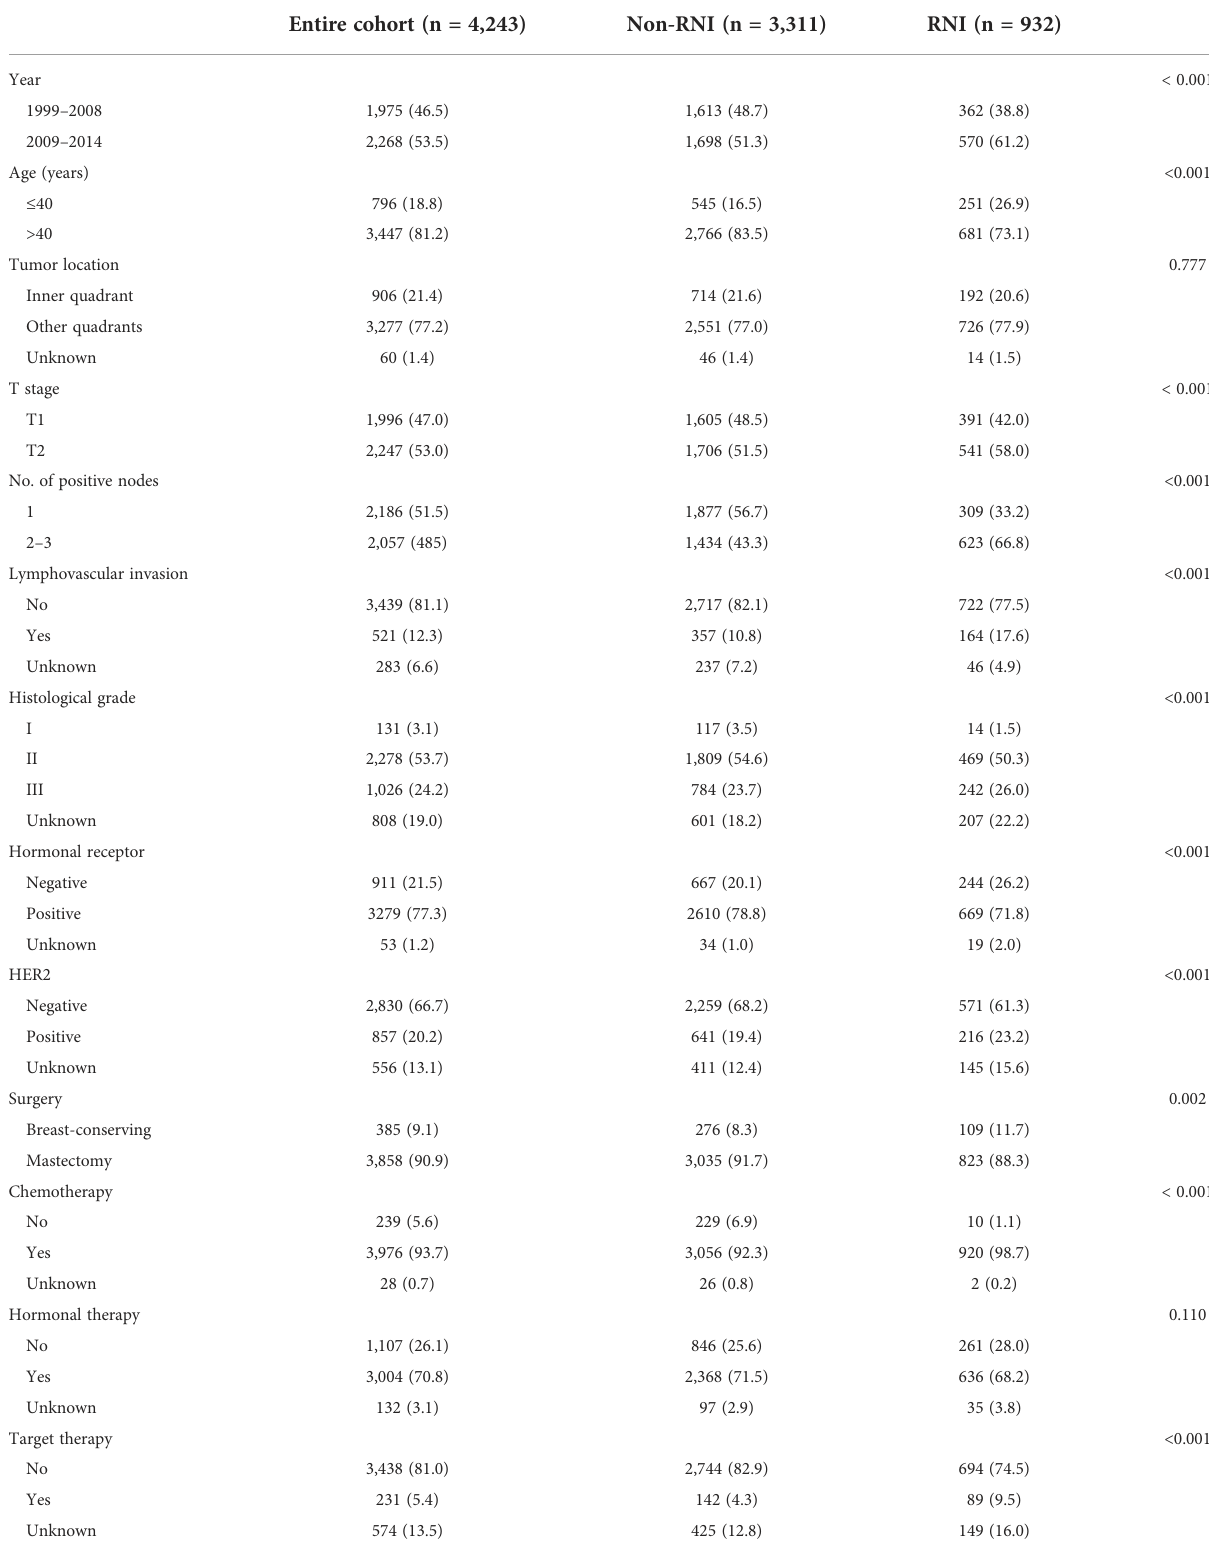
TABLE 1 Baseline characteristics of the entire patient